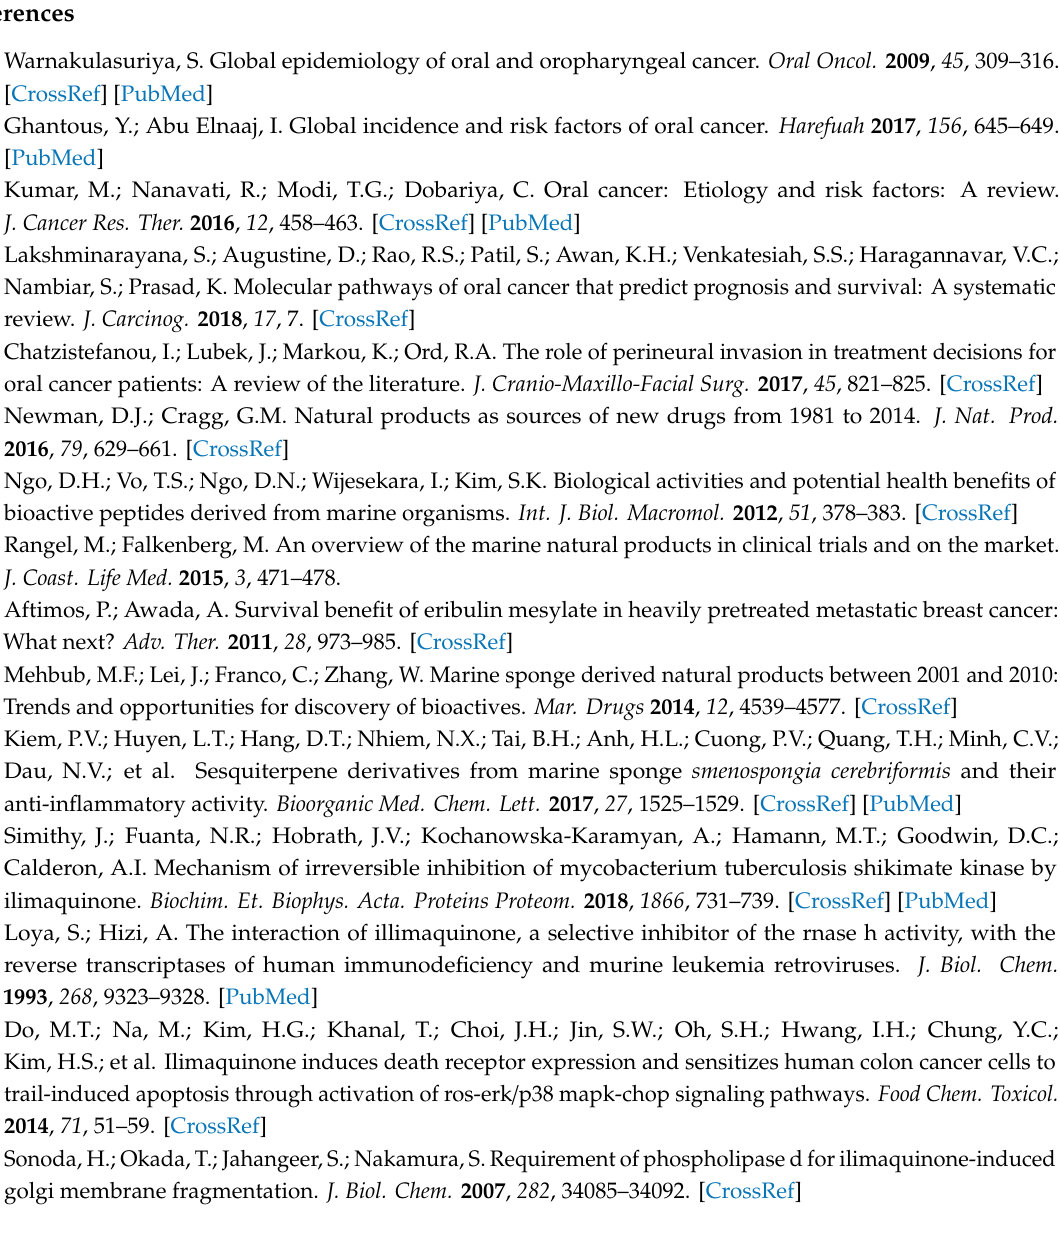
Figure S1: 1 H NMR spectrum of ilimaquinone in CDCl 3 at 400 MHz; Figure S2: 13 C NMR spectrum of ilimaquinone in CDCl 3 at 100 MHz; Figure S3: HMQC spectrum of ilimaquinone in CDCl 3 ; Figure S4: HMBC spectrum